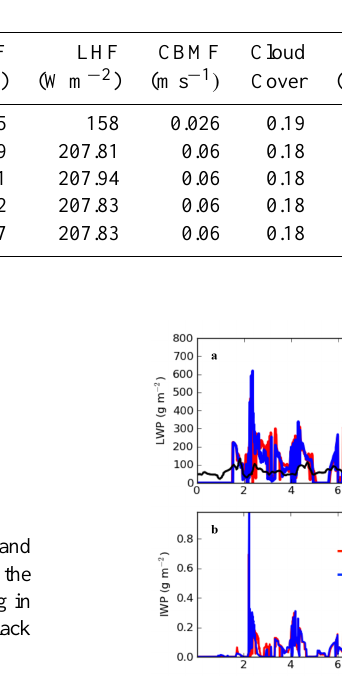
Table 4. Data averaged over the last four 4h of RICO runs. LES data are from VZ11.